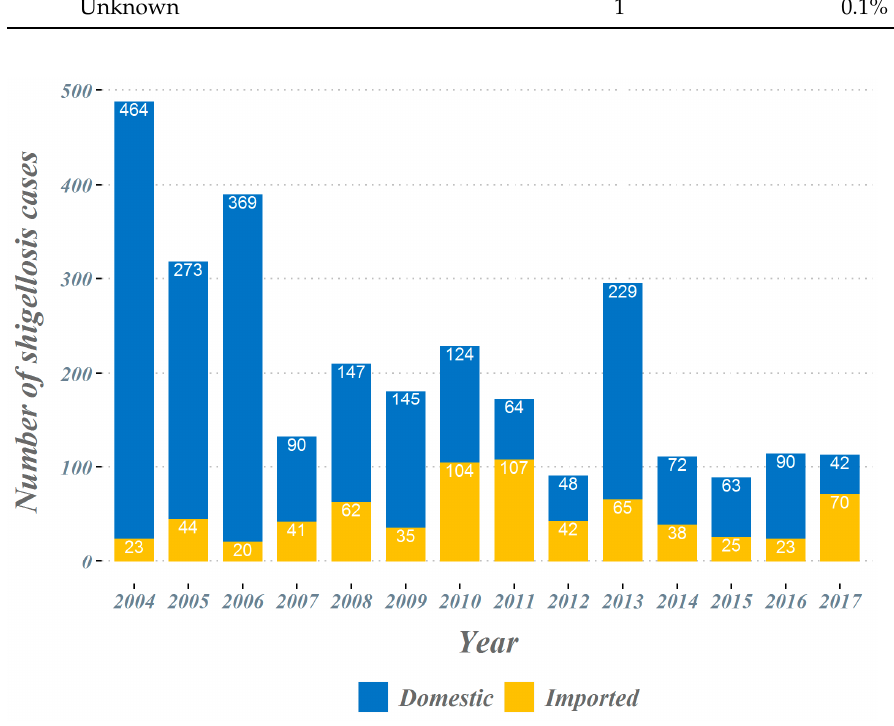
Figure 1. Shigellosis in the Republic of Korea, 2004–2017.